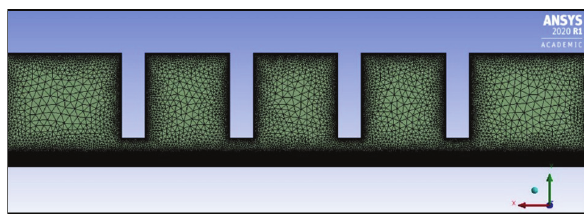
Figure 2. Grid elements used in